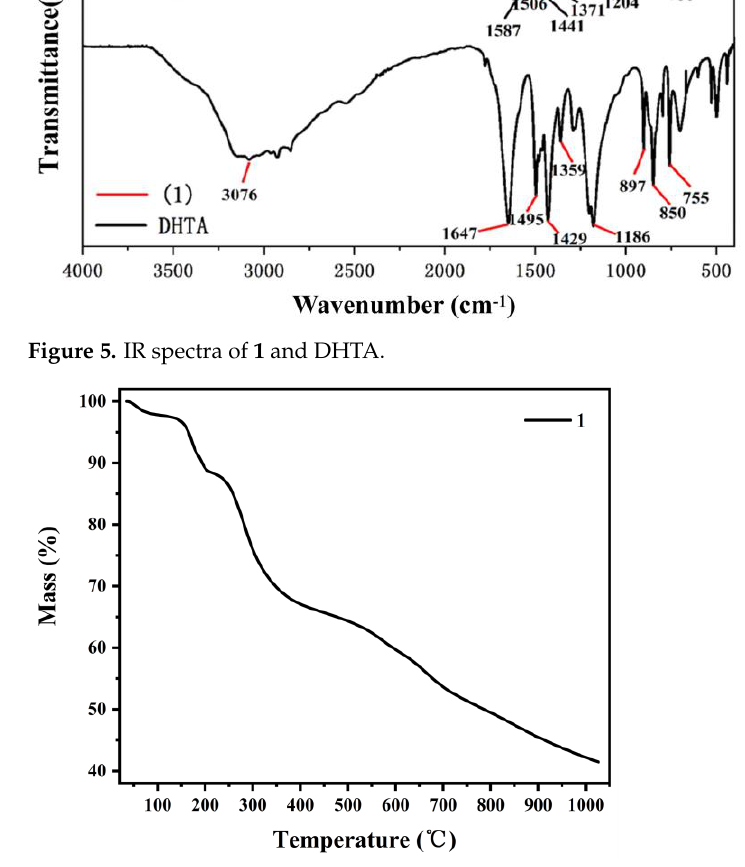
Figure 5. IR spectra of 1 and DHTA.